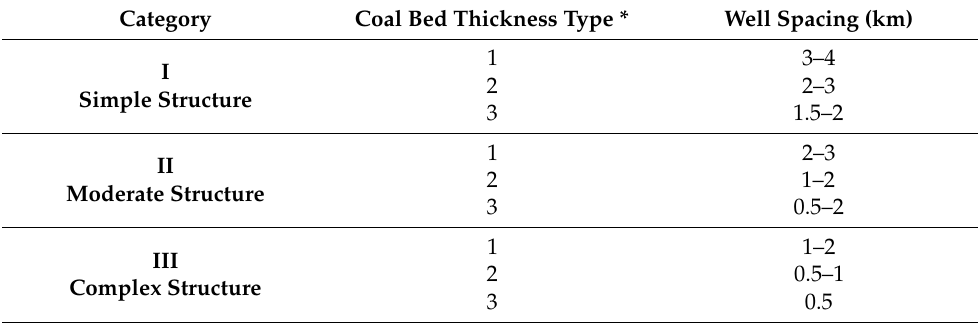
Table 1. Well spacing requirements for different levels of geological complexity as indicated from the Chinese